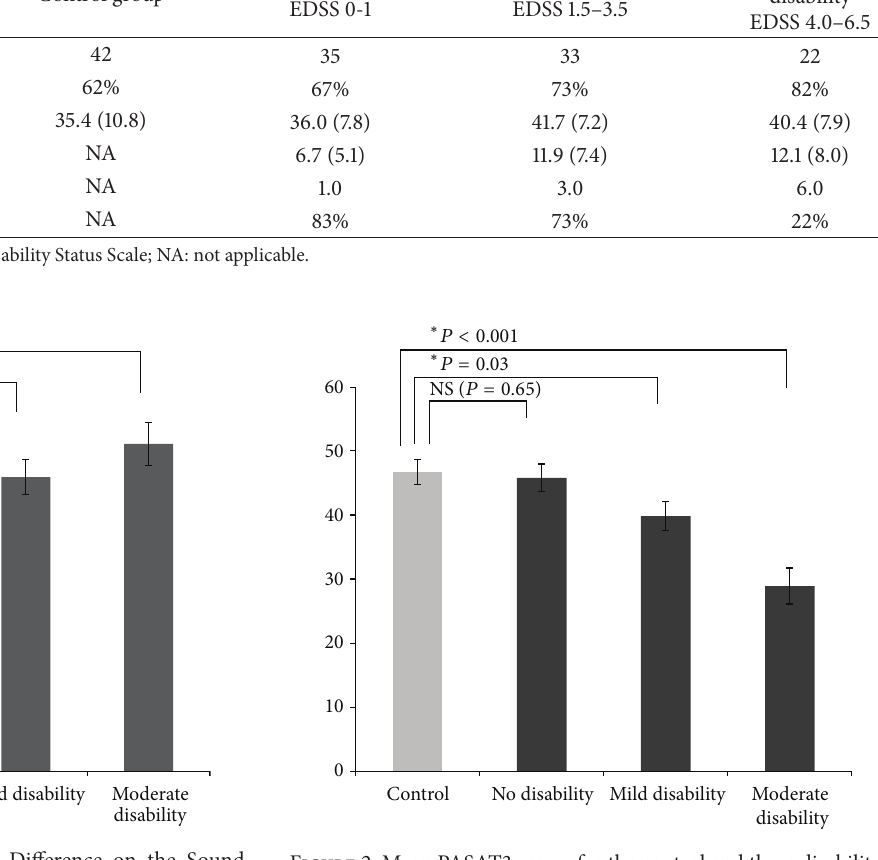
Figure 2: Mean PASAT3 scores for the control and three disability- stratified groups. ∗ Signifies that the difference between the control group and MS groups was statistically significant ( 𝑃 < 0.05